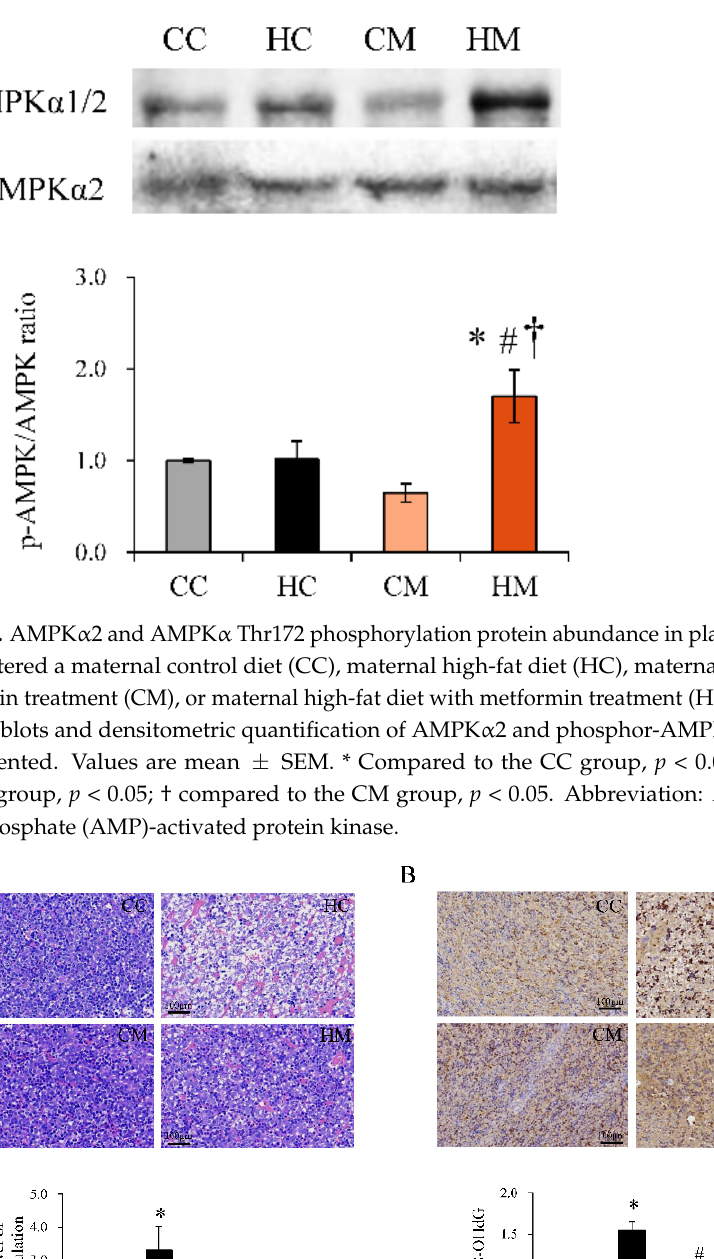
5 of 14 Figure 3. Gene expression of glucose transporters and leptin signaling in placenta tissue. ( A ) GLUT 1, ( B ) GLUT 2, ( C ) GLUT 3, ( D ) GLUT 4, ( E ) leptin, and ( F ) leptin receptor mRNA expression in the placenta tissue of rats administered a maternal control diet (CC), maternal high-fat diet (HC), ma- ternal control diet with metformin treatment (CM), or maternal high-fat diet with metformin treat- ment (HM). * Compared to the CC group, p < 0.05; # compared to the HC group, p < 0.05; † compared to the CM group, p < 0.05. Abbreviation: GLUT, glucose transporter; LepR, leptin receptor. 2.4. Maternal Metformin Treatment Activates 5’ Adenosine Monophosphate-Activated Protein Kinase (AMPK) Signaling in the Placenta